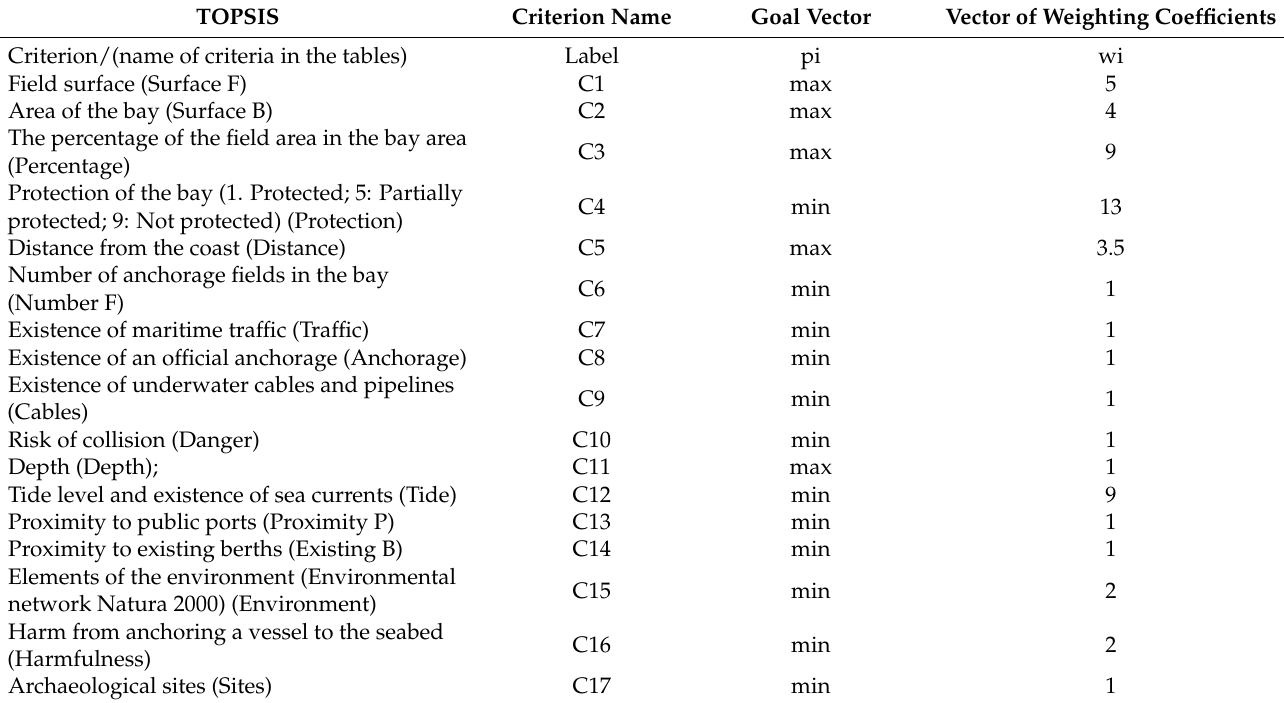
Table 7. Elements of the goal vector and their weight values when applying TOPSIS